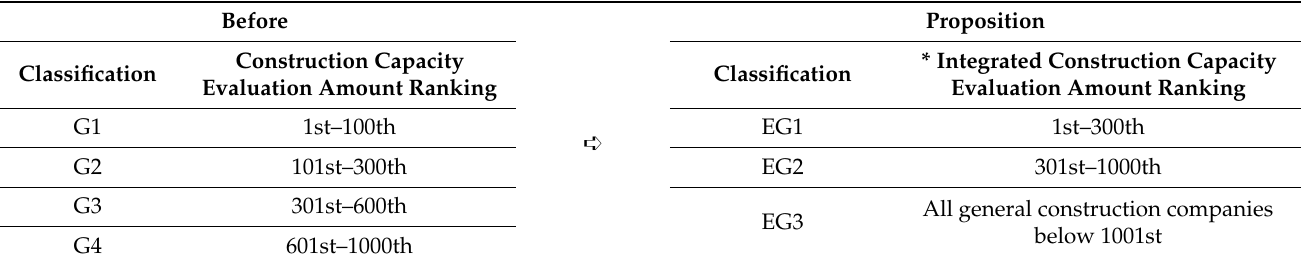
Table 8. Proposal of classification system for evaluation